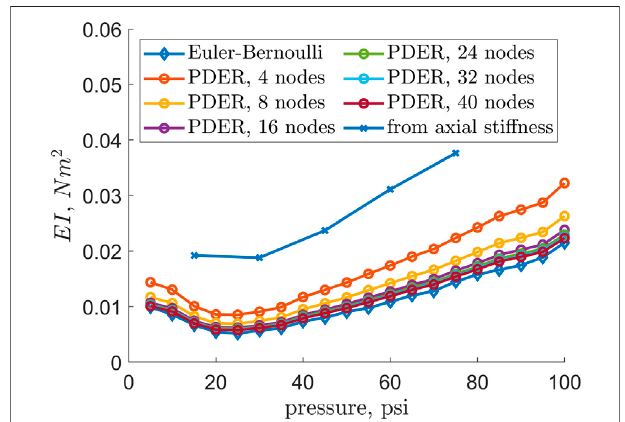
FIGURE 5 | Bending stiffness of an EFAM versus EFAM internal pressure. The blue line represents bending stiffness recalculated from axial rigidityexperimentaldata.Theredandyellowlinesrepresent bendingstiffness obtained through tip error minimization procedure for PDER models and Euler-Bernoulli models, respectively.